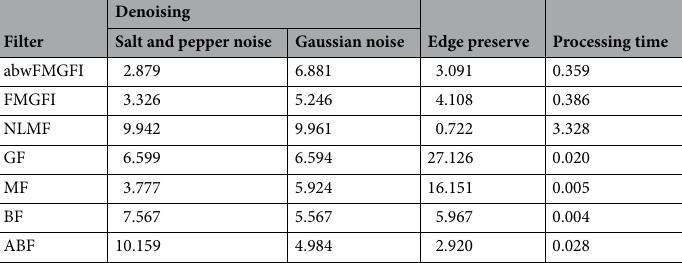
Table 18. Quantitative comparison of filter performances.